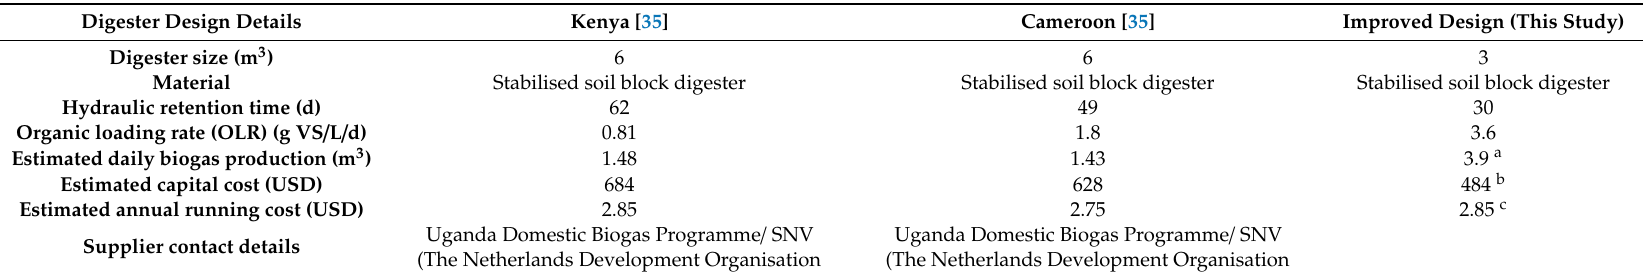
Table 3. Optimal digester design for rural Kenyan and Cameroonian households, and optimised digester in this